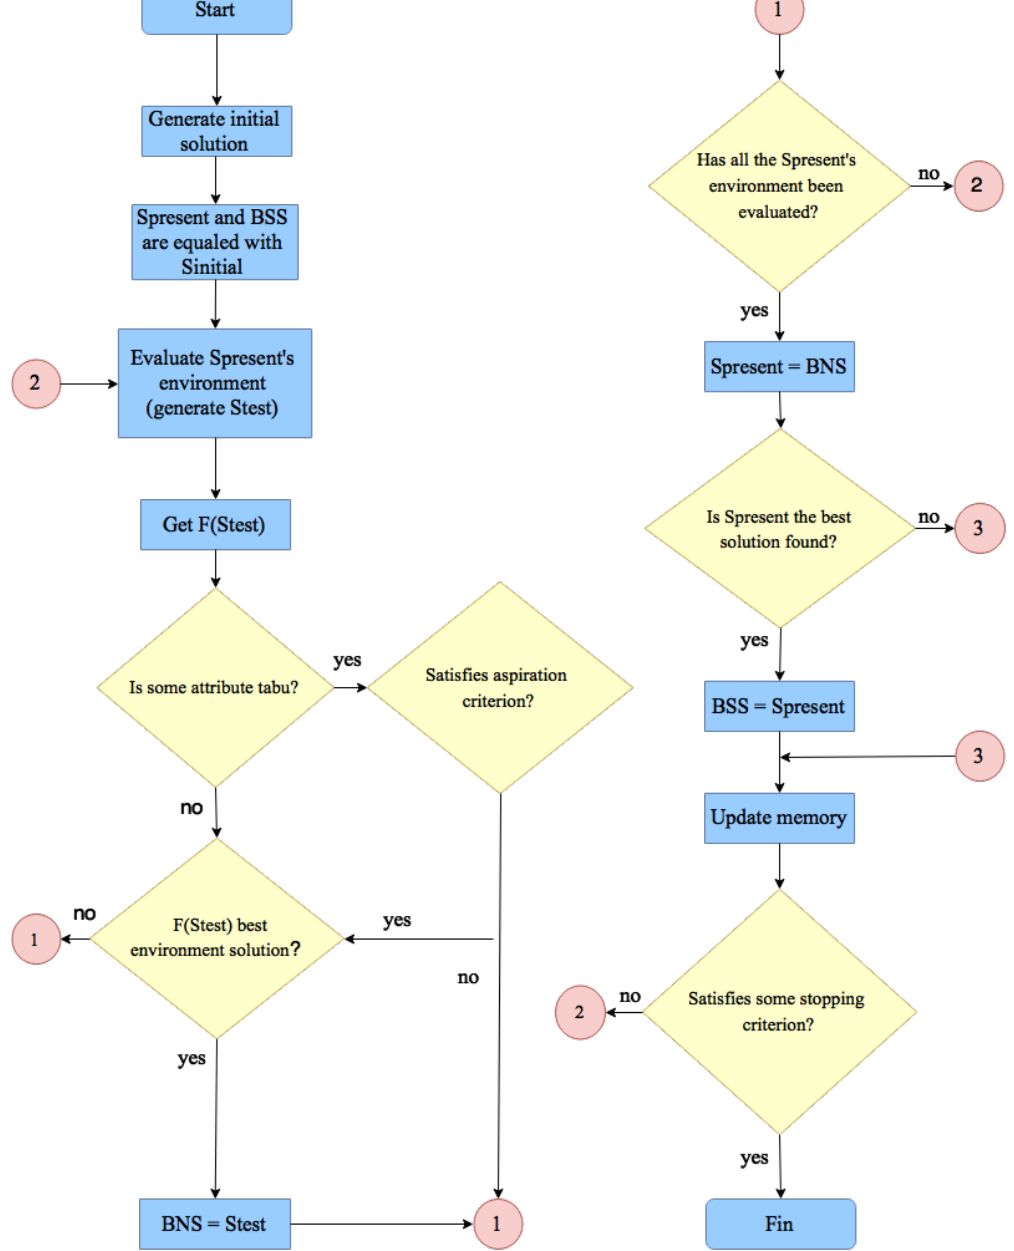
Figure 2. Search algorithm of the PSS parameters. Tabu search